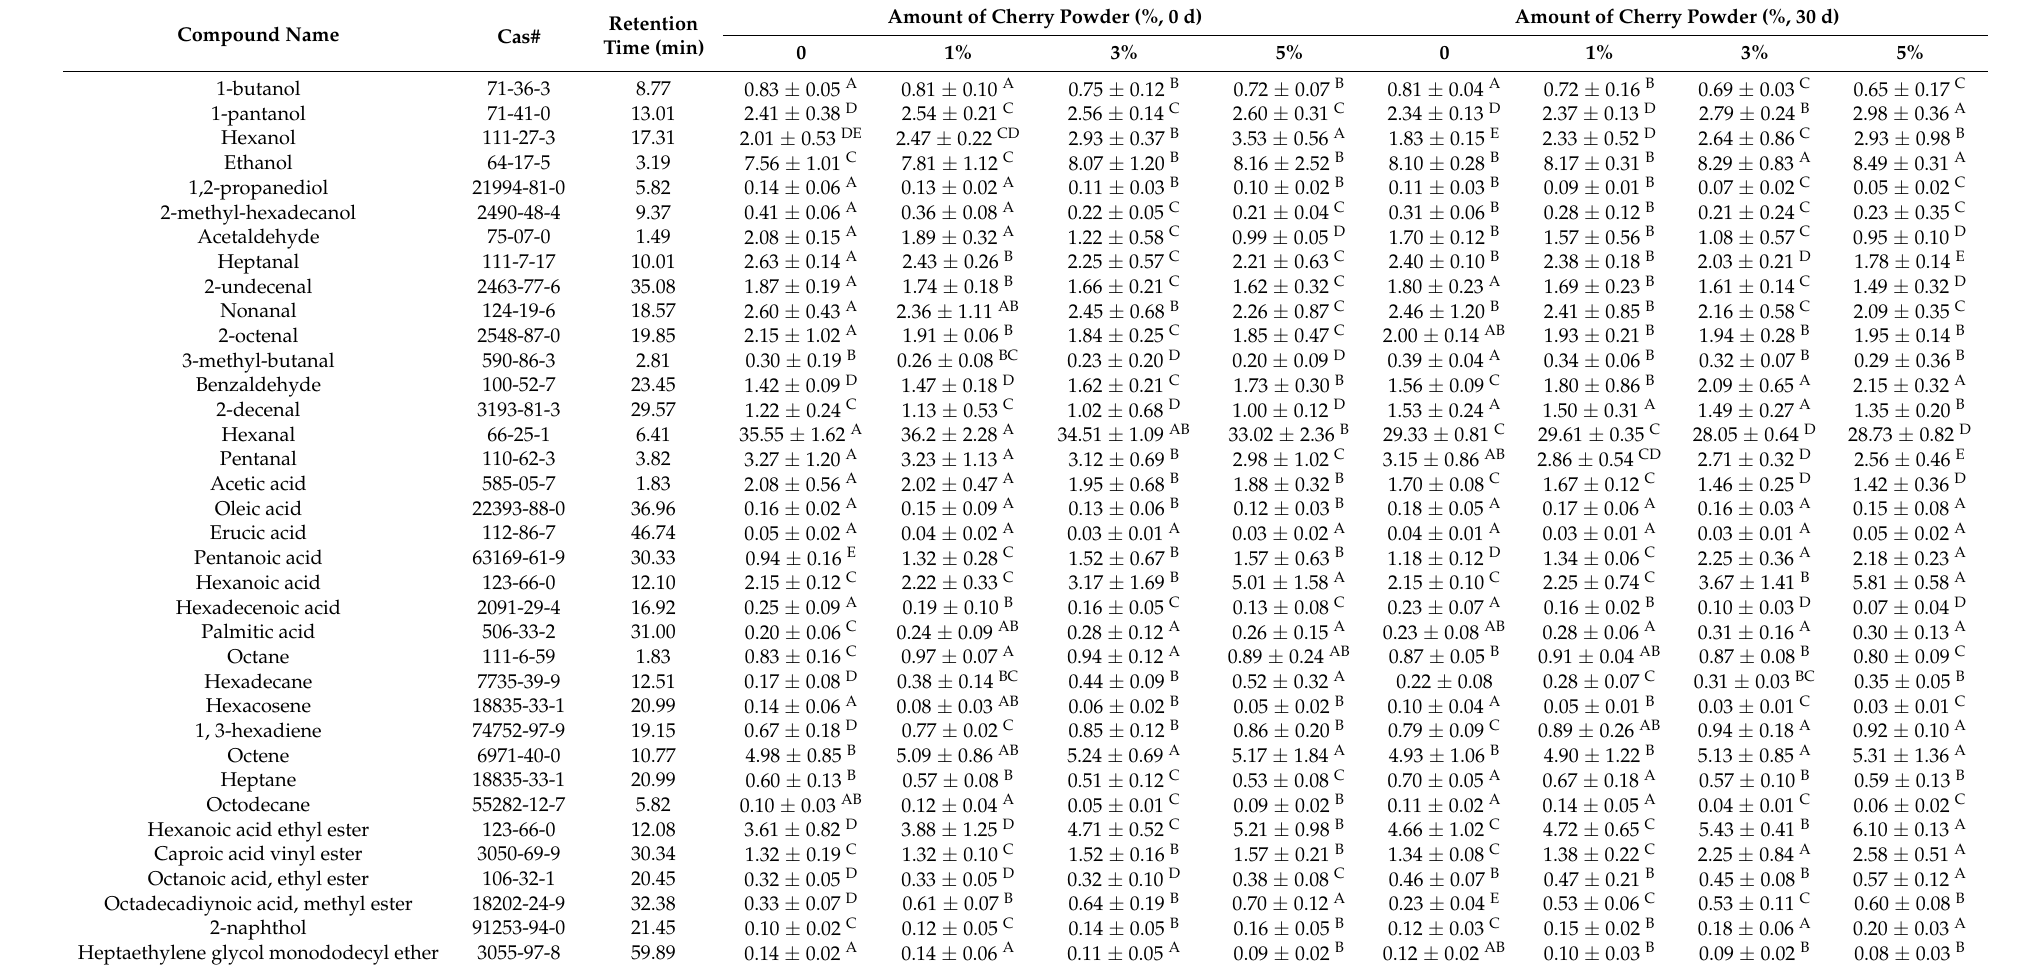
Table 3. Effects of cherry powder addition on volatile flavor components of Jiangsu-type sausage during